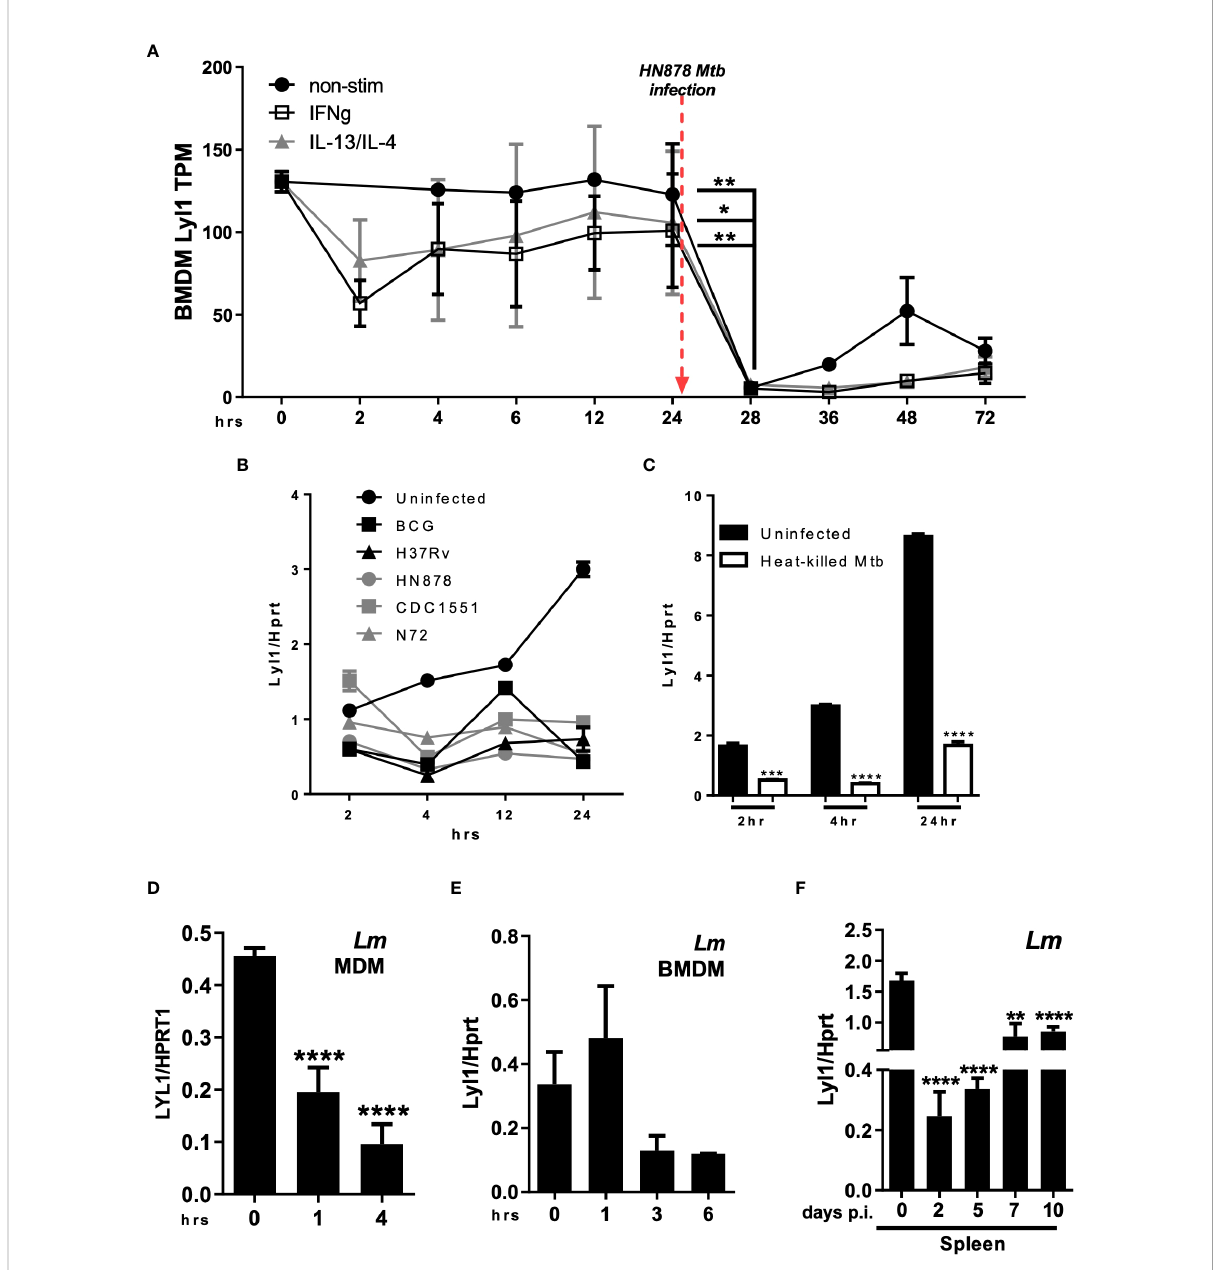
FIGURE 1 Regulation of Lyl1 expression is a host-driven mechanism. (A) Expression kinetics (represented as Tags Per Million (TPM)) of Lyl1 in Mtb HN878 infected mouse bone marrow-derived macrophage (BMDM) data were extracted from the FANTOM5 mouse macrophages dataset. (B) Lyl1 mRNA expression was measured by RT-qPCR, relative to the Hprt housekeeping gene, in BMDM infected with various Mtb strains, as well as (C) heat-killed Mtb at MOI:1. (D) MDM derived from healthy participants were infected with Lm with MOI:10 to measure LYL1 mRNA expression kinetics. (E) BMDM were infected with Listeria monocytogenes ( Lm ) with MOI:10 for RNA collection. (F) A total of 2x10 5 CFU/mouse of Lm was intraperitoneally injected into C57BL/6 mice ( n = 3 mice/group) after which the spleen and liver were collected at indicated time points for RNA isolation. Error bar denotes Mean ± SEM. Data shown are representative of 2-4 independent experiments. Unpaired student t-test analysis at * p < 0.05, ** p < 0.01, *** p < 0.001, **** p < 0.0001 to determine signi fi